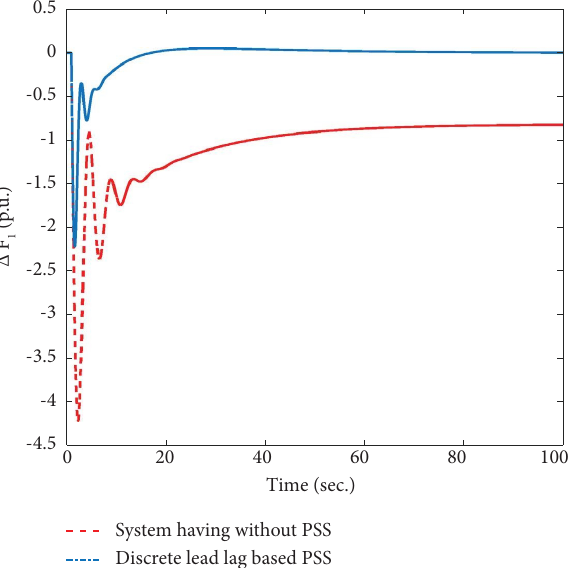
Figure 5: Frequency deviation in area-1 Δ F 1 (p.u.) with respect to time (sec) for without having any PSS and with the discrete lead- lag-based PSS.